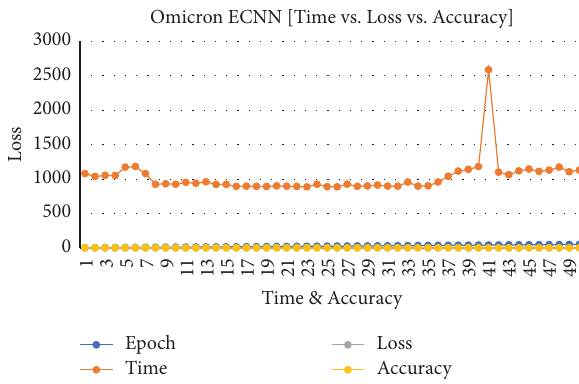
Figure 7: Omicron disease ECNN data accuracy vs. loss vs. time.